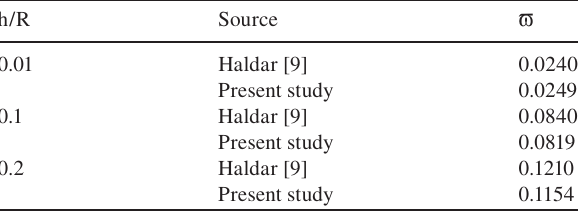
Convergence study of the present study for isotropic skew = 60 ° , L/R = 4). open cylindrical shell ( α= 45 ° , θ o Source ϖ